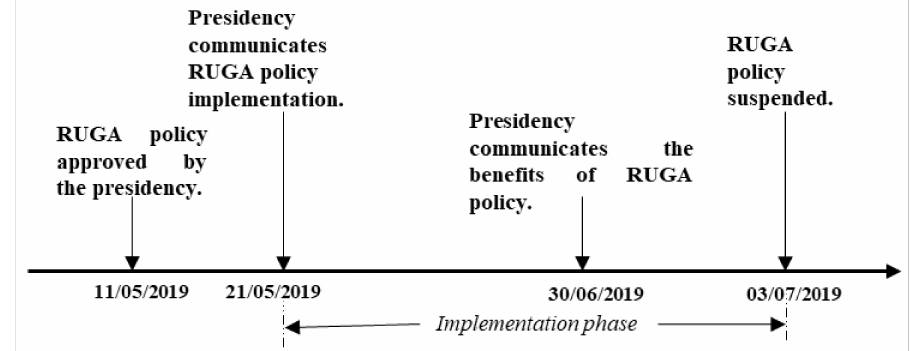
Figure 1. Timeline of the RUGA policy.